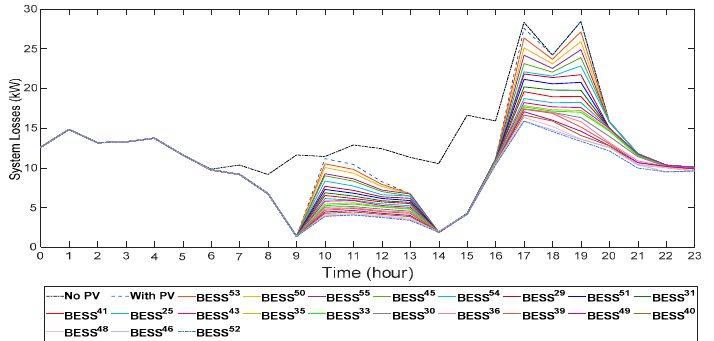
Figure 9. System losses with different numbers of BESS.